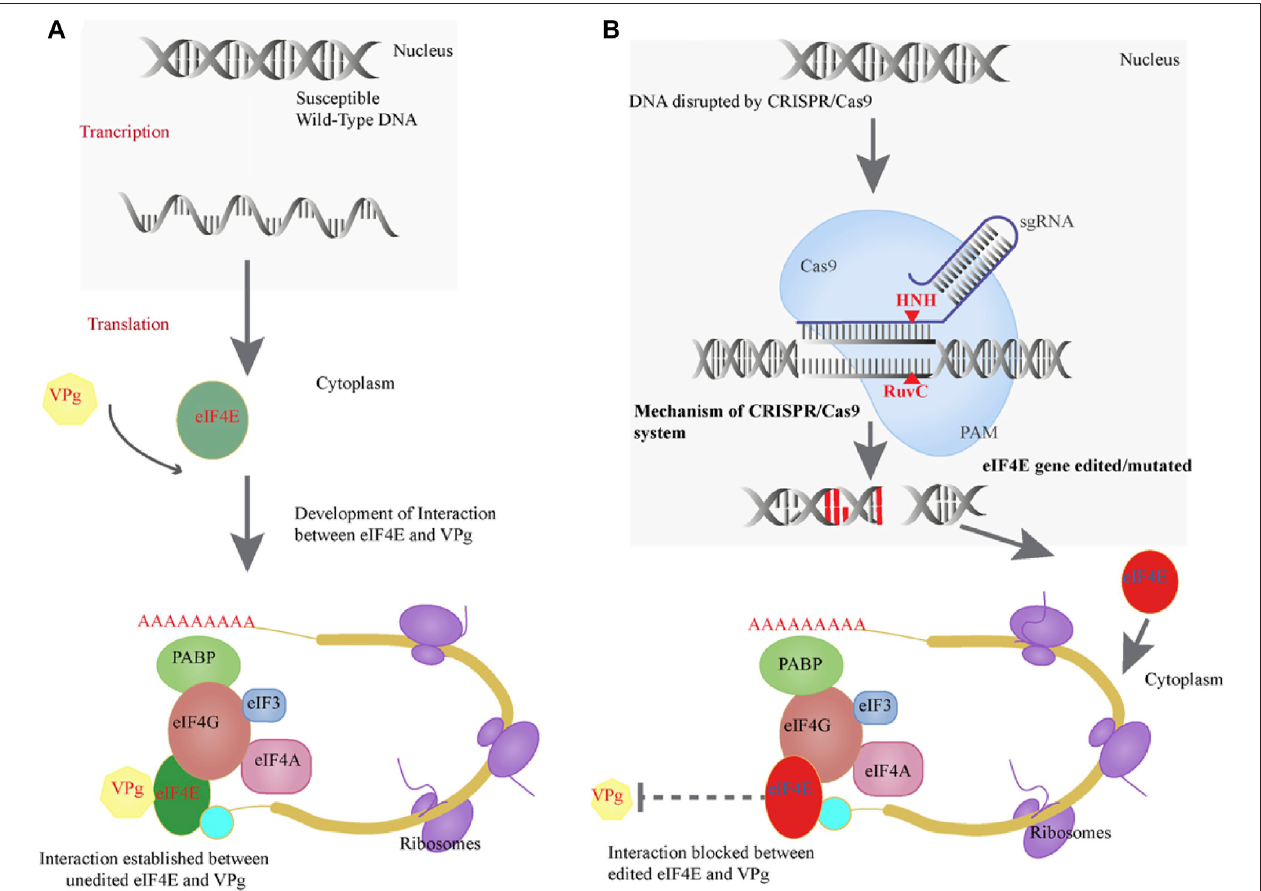
FIGURE 5 | (A) Positive interaction of eIF4E protein of potato and VPg of PVY. (B) Genome editing ef fi ciency of CRISPR/Cas and how it mutates the eIF4E and blocks the VPg – eIF4E interaction.